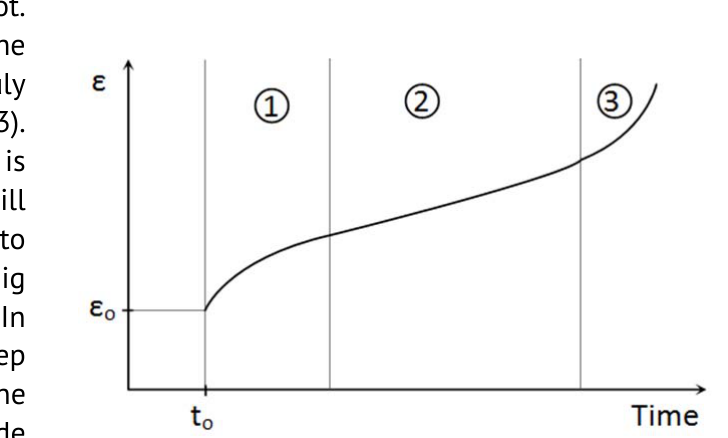
Figure 13. The typical curve of strain versus time to represent creep behaviour at constant constraint and temperature. Creep is divided in three